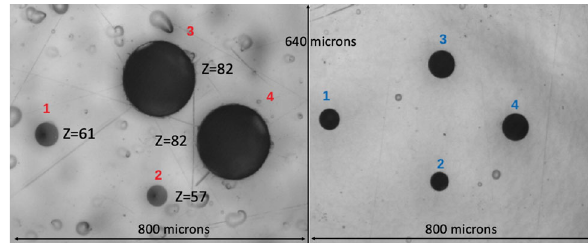
Fig. 8 Microphotographs of relativistic Pb 82 + tracks and of nuclear fragments (Z < 82) in two consecutive foils of Makrofol. Each image frame measures 0.64 mm × 0.80 mm. Etch-pits are from the same ions crossing the detector foils: (left) Makrofol foil etched in “strong condi- tions”; (right) Makrofol foil etched in “soft conditions” . Note that the microphotographs also show two clearly differentiated fragmentation products of Pb: La (Z = 57); and, Pm (Z = 61)